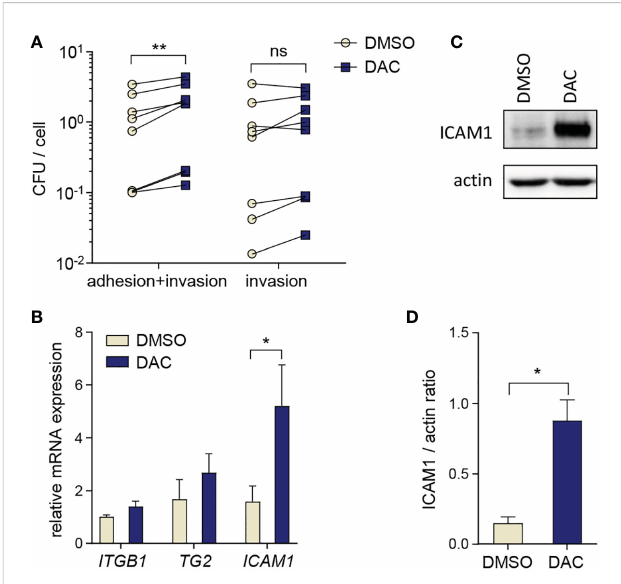
FIGURE 4 DAC promotes P. gingivalis adhesion to GFs. (A) Bacterial adhesion and intracellular survival determined by the colony forming assay in GFs (n=8) treated for 12 days with DMSO or DAC. Individual values of CFU counts per cell with lines connecting DMSO- and DAC-treated cells from individual donors are shown. (B) qPCR analysis of ITGB1 , TG2 and ICAM1 in DMSO- and DAC-treated GFs (n=5). (C, D) Western blot analysis of ICAM1 and actin in GFs after 12 days of culture with DMSO or DAC. A representative of 4 independent experiments (C) and the ratio of ICAM1/actin signal intensity from densitometric analysis (n=4) (D) are shown. ns, not signi fi cant; *P < 0.05, **P <